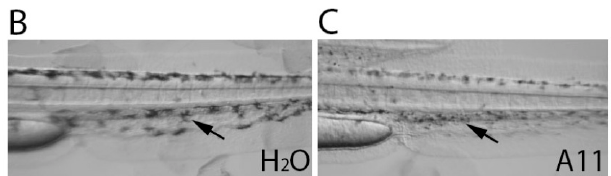
Figure 4. A11 reduces existing pigment. ( A ) Embryos at 48 hpf stage that already generated lots of pigment were selected for this experiment to receive compound treatment until 72 hpf and then were photographed. A11 caused significant pigment reduction compared to the control at 72 hpf (even less than 48 hpf normal embryo in Figure 3). High magnification of H 2 O ( B ) and A11 ( C ) treated embryos are shown to display the contracted morphology of melanocytes (arrows).